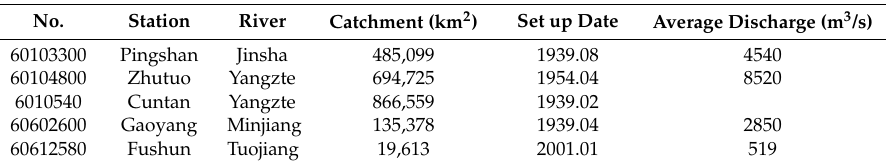
Table 2. Hydrological stations along the study area.